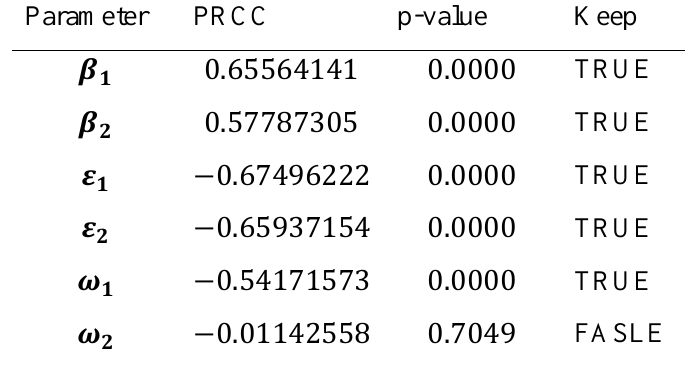
Table 2. Parameter PRCC significance (unadjusted